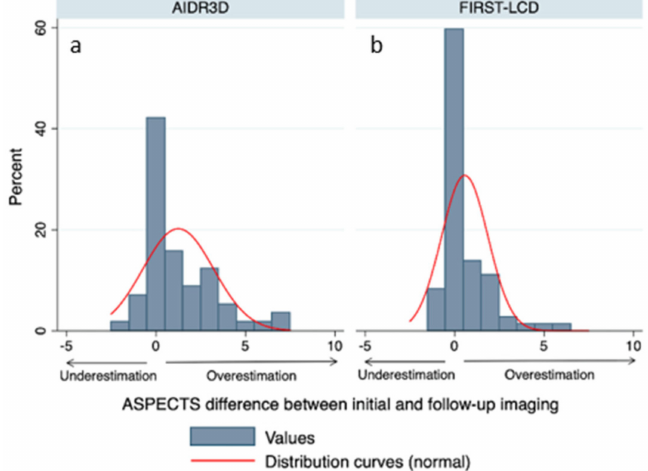
Figure 1. ASPECTS difference between initial FIRST-LCD ( b ) and AIDR3D ( a ) and follow-up imaging (final ASPECTS). The narrower the distribution curve, the higher the distribution curve near 0. FIRST-LCD ASPECTS ( b ) more closely match the final ASPECTS than AIDR3D ASPECTS ( a